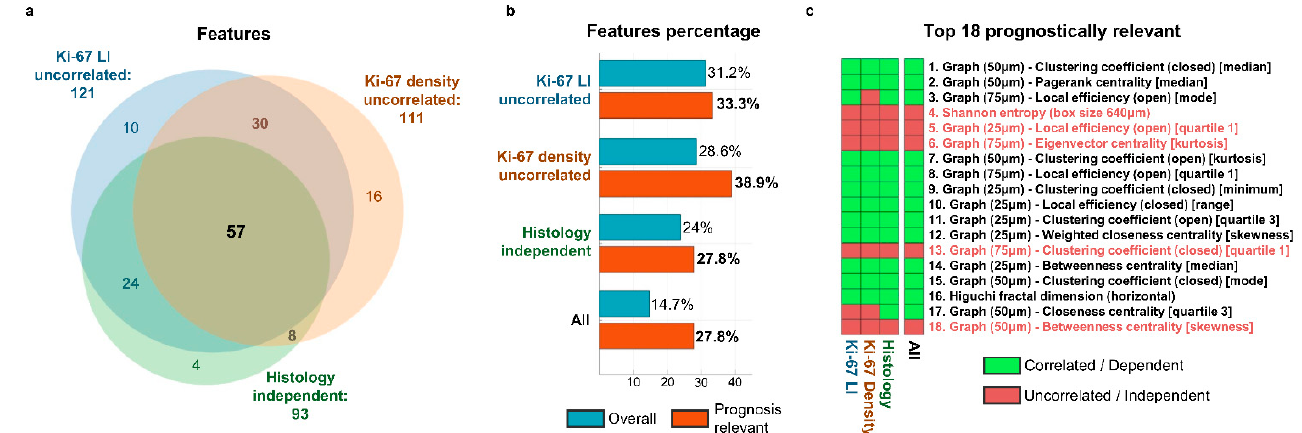
Figure 5. ( a ) Venn diagram depicting the relationships and overlaps between three relevant sets of features: those uncorrelated with Ki-67 LI (121, in total), the ones uncorrelated with the density of Ki-67 + cells (111) and the histology-independent ones (93). ( b ) Percentage of features belonging to each of the three mentioned feature sets and to their intersection. Blue bars indicate the percentage among the total 388 features remaining after preliminary filtering, red bars the percentage in the 18 most prognostically relevant. ( c ) List of the 18 most prognostically relevant features. The corresponding heatmap shows whether they belong to any of the previously presented feature sets (in red) or not (in green).